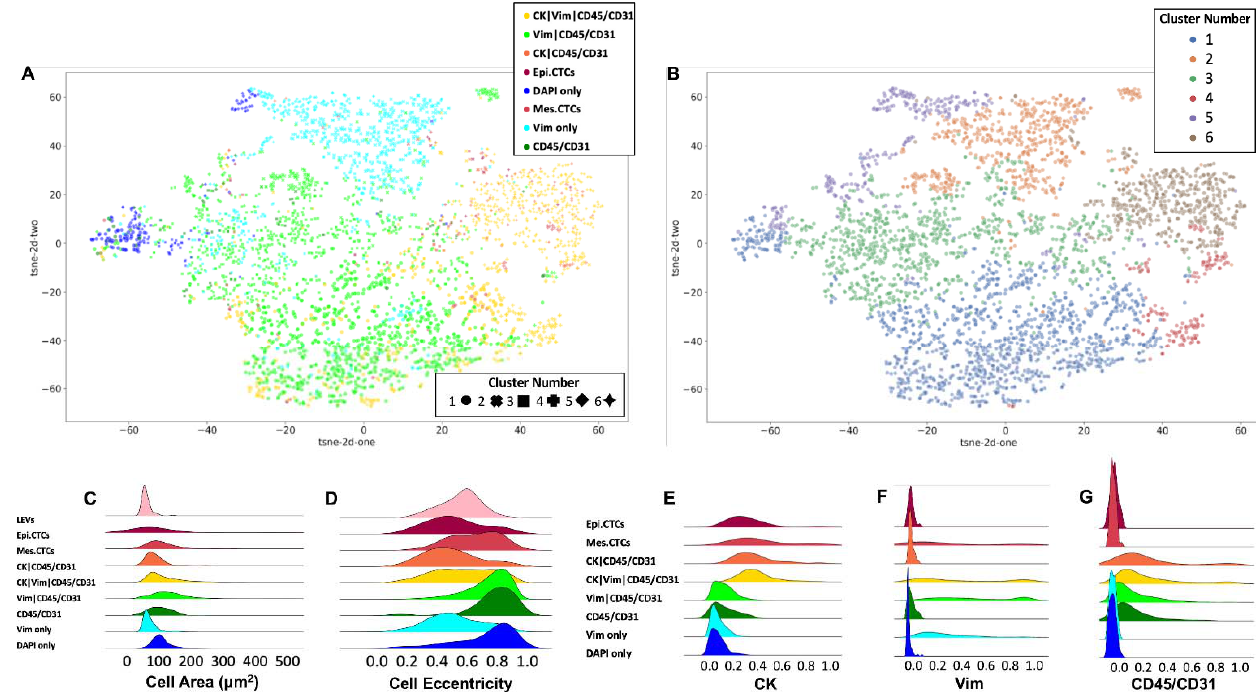
Figure 3. Morphometric analysis of individual events detected by HDSCA3.0 in PB samples collected from patients with UTUC prior to RNU. Depicted is a tSNE plot of rare cellular events depicting the underlying morphological heterogeneity. Each point represents a single cell and is color-coded according to ( A ) its channel-type classification and ( B ) a distinct cluster number, as determined by a clustering algorithm. Also visualized are the probability density distributions for select morphometric parameters across channel-type classifications of ( C ) cell area, ( D ) cell eccentricity, ( E ) median CK signal intensity, ( F ) median Vim signal intensity, and ( G ) median CD45/CD31 signal intensity.